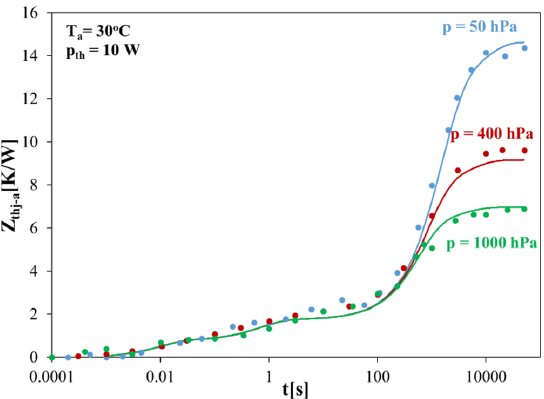
Figure 3. Measured and computed waveforms of transient thermal impedance of the tested diode for three values of atmospheric